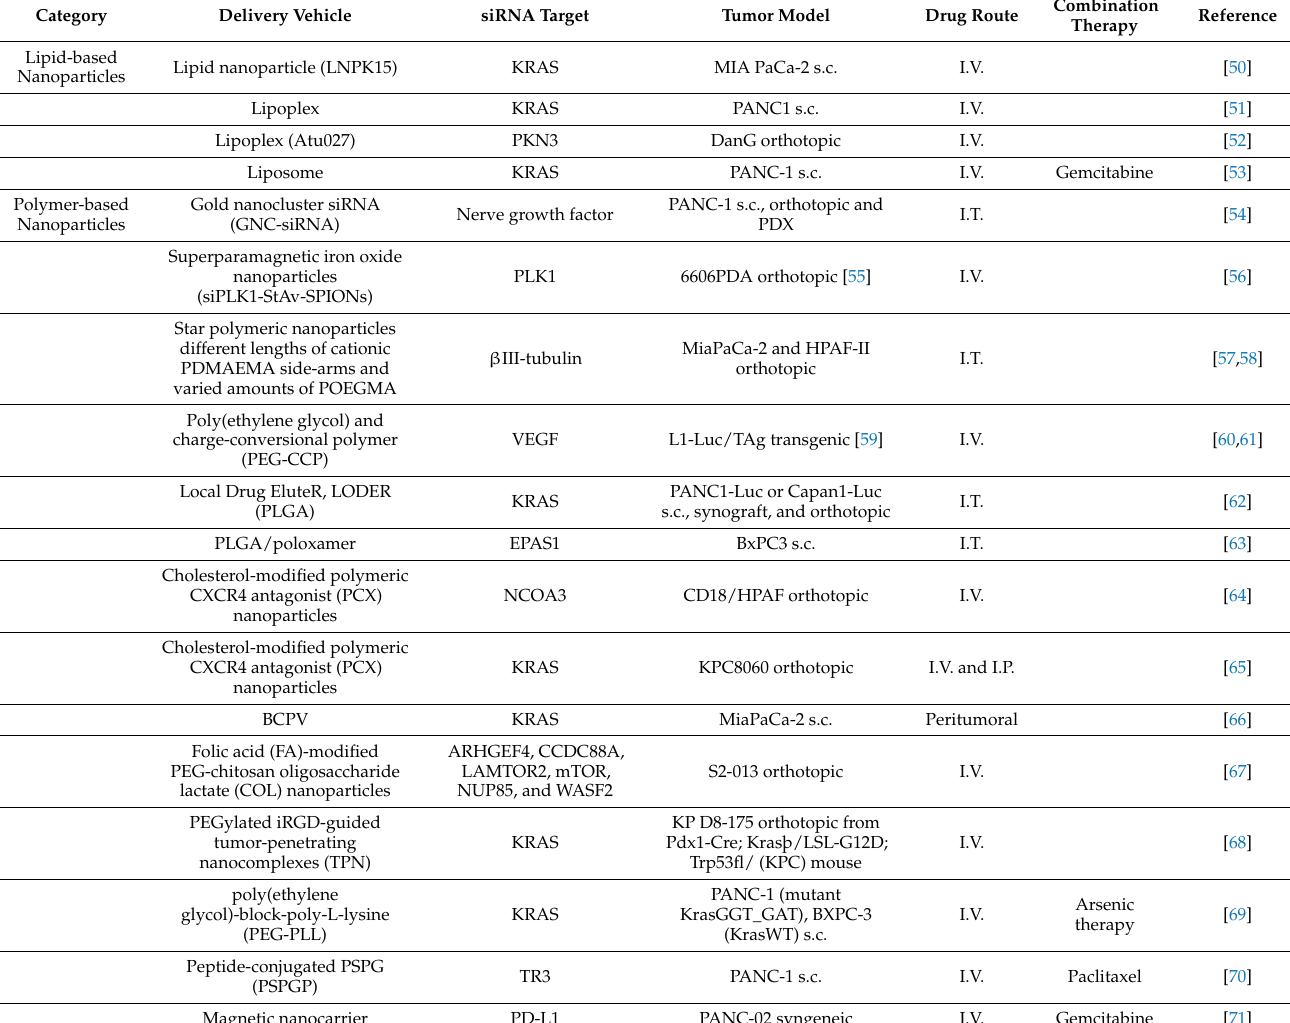
Table 2. siRNA-based therapeutics in preclinical pancreatic cancer